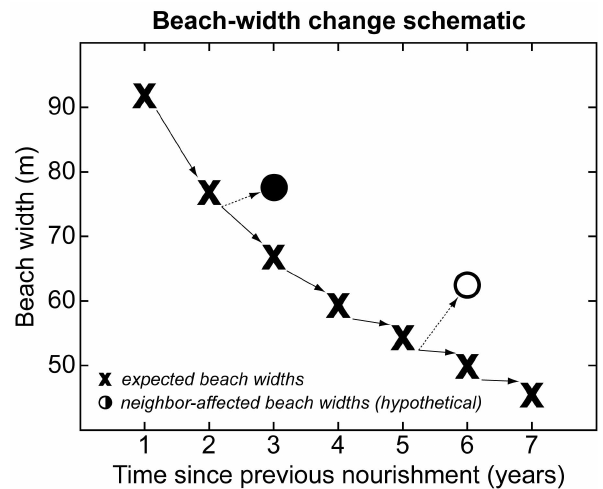
Fig. 3. Schematic of beach-width through time for a given model town. If a delivery of diffused sand arrives late in the erosion cycle (open circle), where linear erosion predominates, manager agents decrease γ p . Agents interpret an early-cycle delivery of sand (closed circle) as a change in the exponential erosion rate, prompting them to increase θ p and decrease γ p